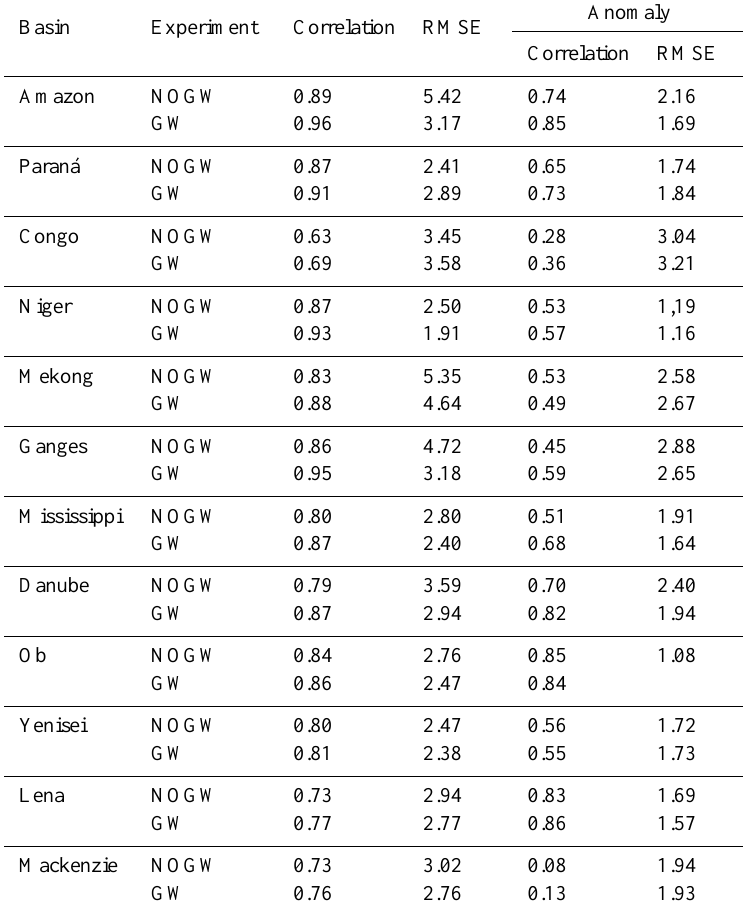
Table 4. Correlation and RMSE (cm) of the spatial mean 1 TWS of NOGW and GW calculated over the whole GRACE period for each river basin shown in Fig. 8. Statistics are also shown for the monthly